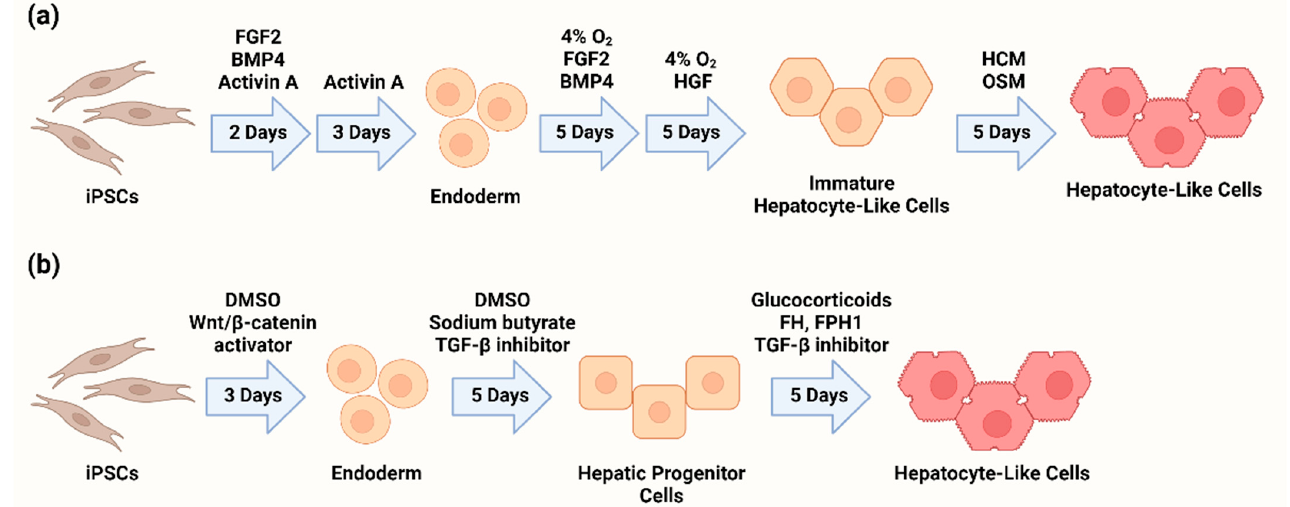
Figure 1. Abridged protocols for the differentiation of hepatocyte-like cells from iPSCs using ( a ) recombinant growth factors [13,16] or ( b ) small molecules [21].